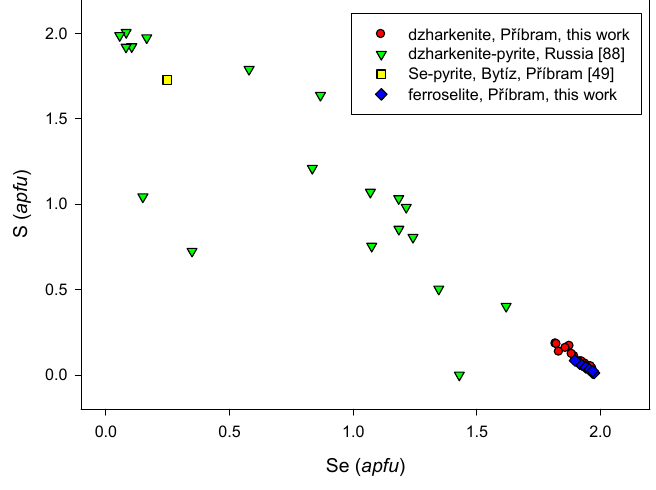
Figure 30. Se vs. S ( apfu ) graph of dzharkenite, ferroselite, and Se-pyrite from various localities.